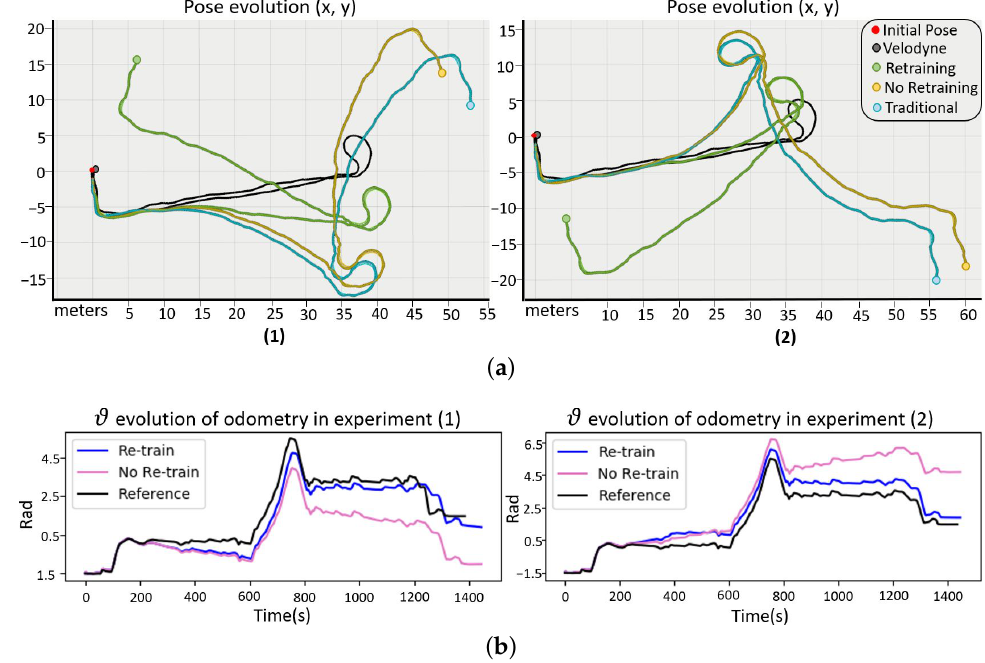
Figure 9. Example paths to validate the calibration model by retraining in real-time. ( a ) Shows the position “X, Y” and ( b ) shows the orientation “ θ